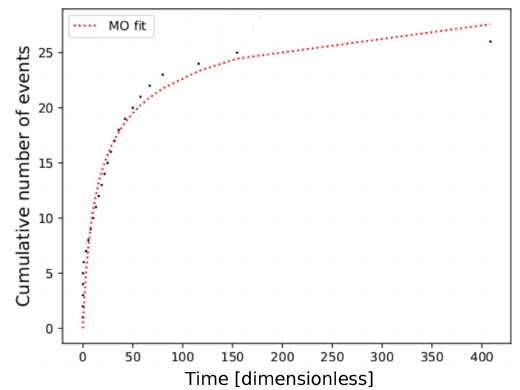
Figure 11. MO fitting for the leading aftershock (LA) series com- puted for the same synthetic series of Fig.